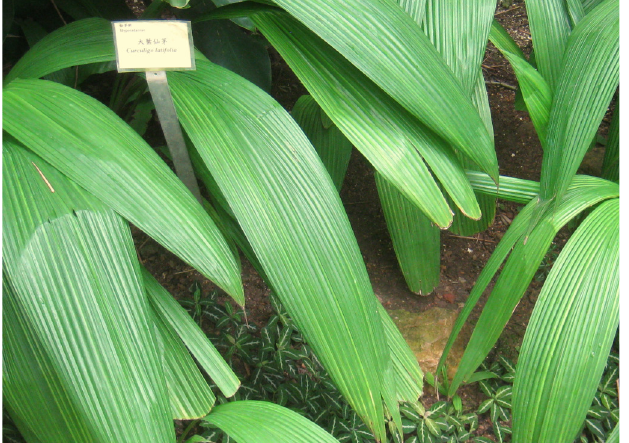
Fig. 1: Curculigo latifolia